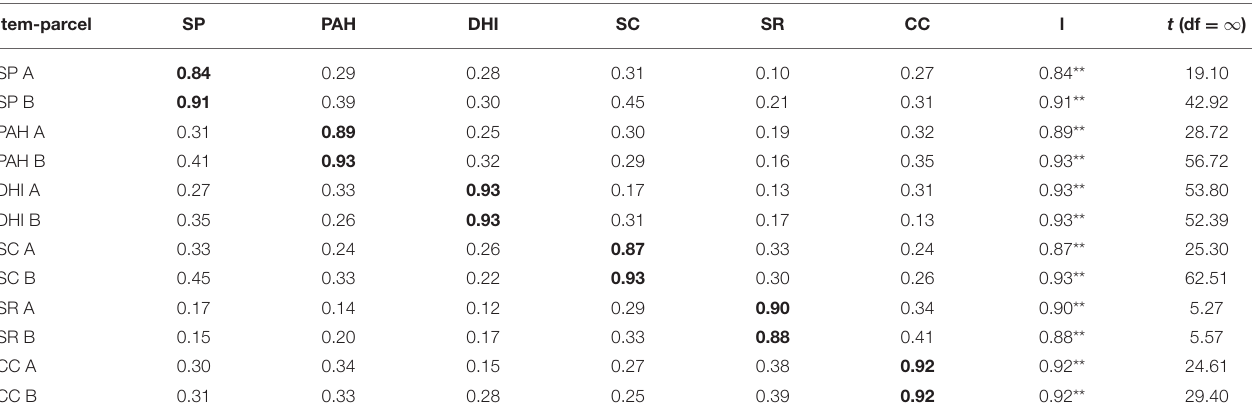
TABLE 3 | Cross loadings of item-parcels in Lenartz’s health literacy questionnaire as indicator for discriminant validity. Item-parcel